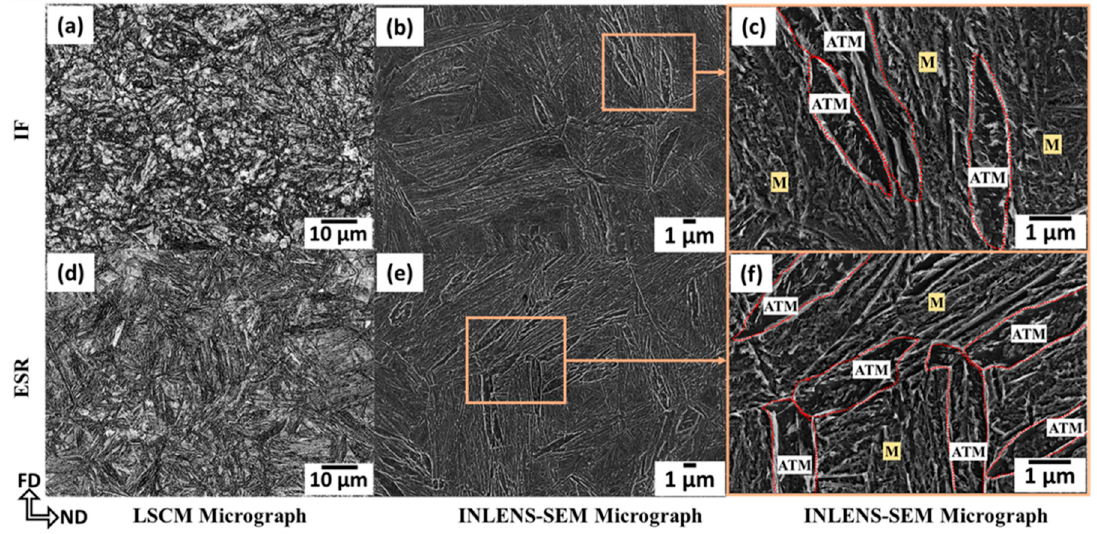
Figure 2. Laser and INLENS-SEM micrographs of UHSS I (IF) without ESR ( a , b, and c ) and with ESR ( d , e and f ). M: Martensite and ATM: auto-tempered martensite.